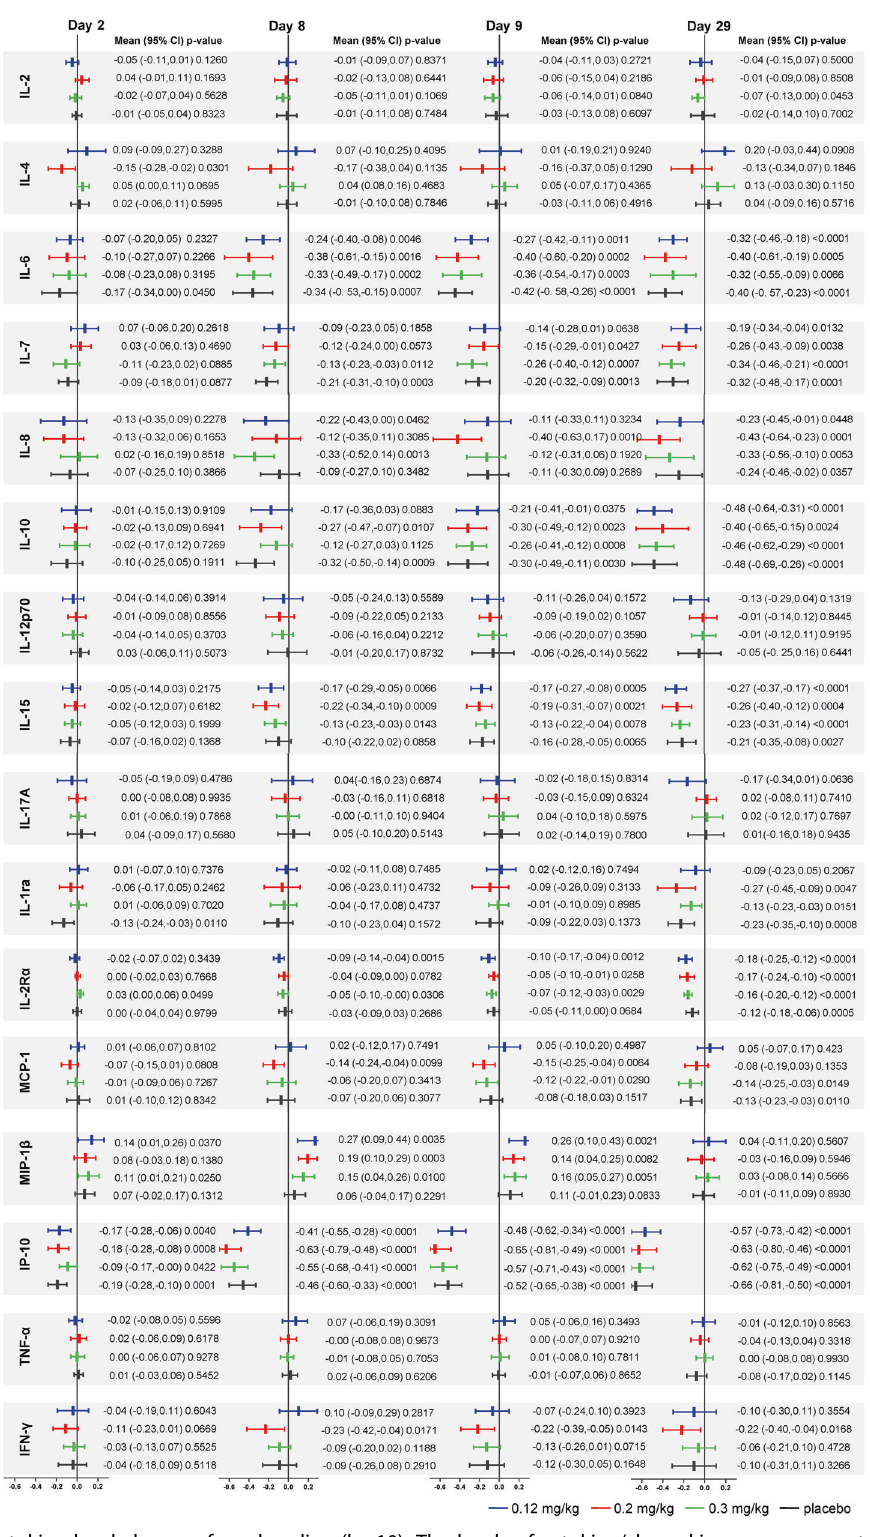
Signal Transduction and Targeted Therapy (2023)